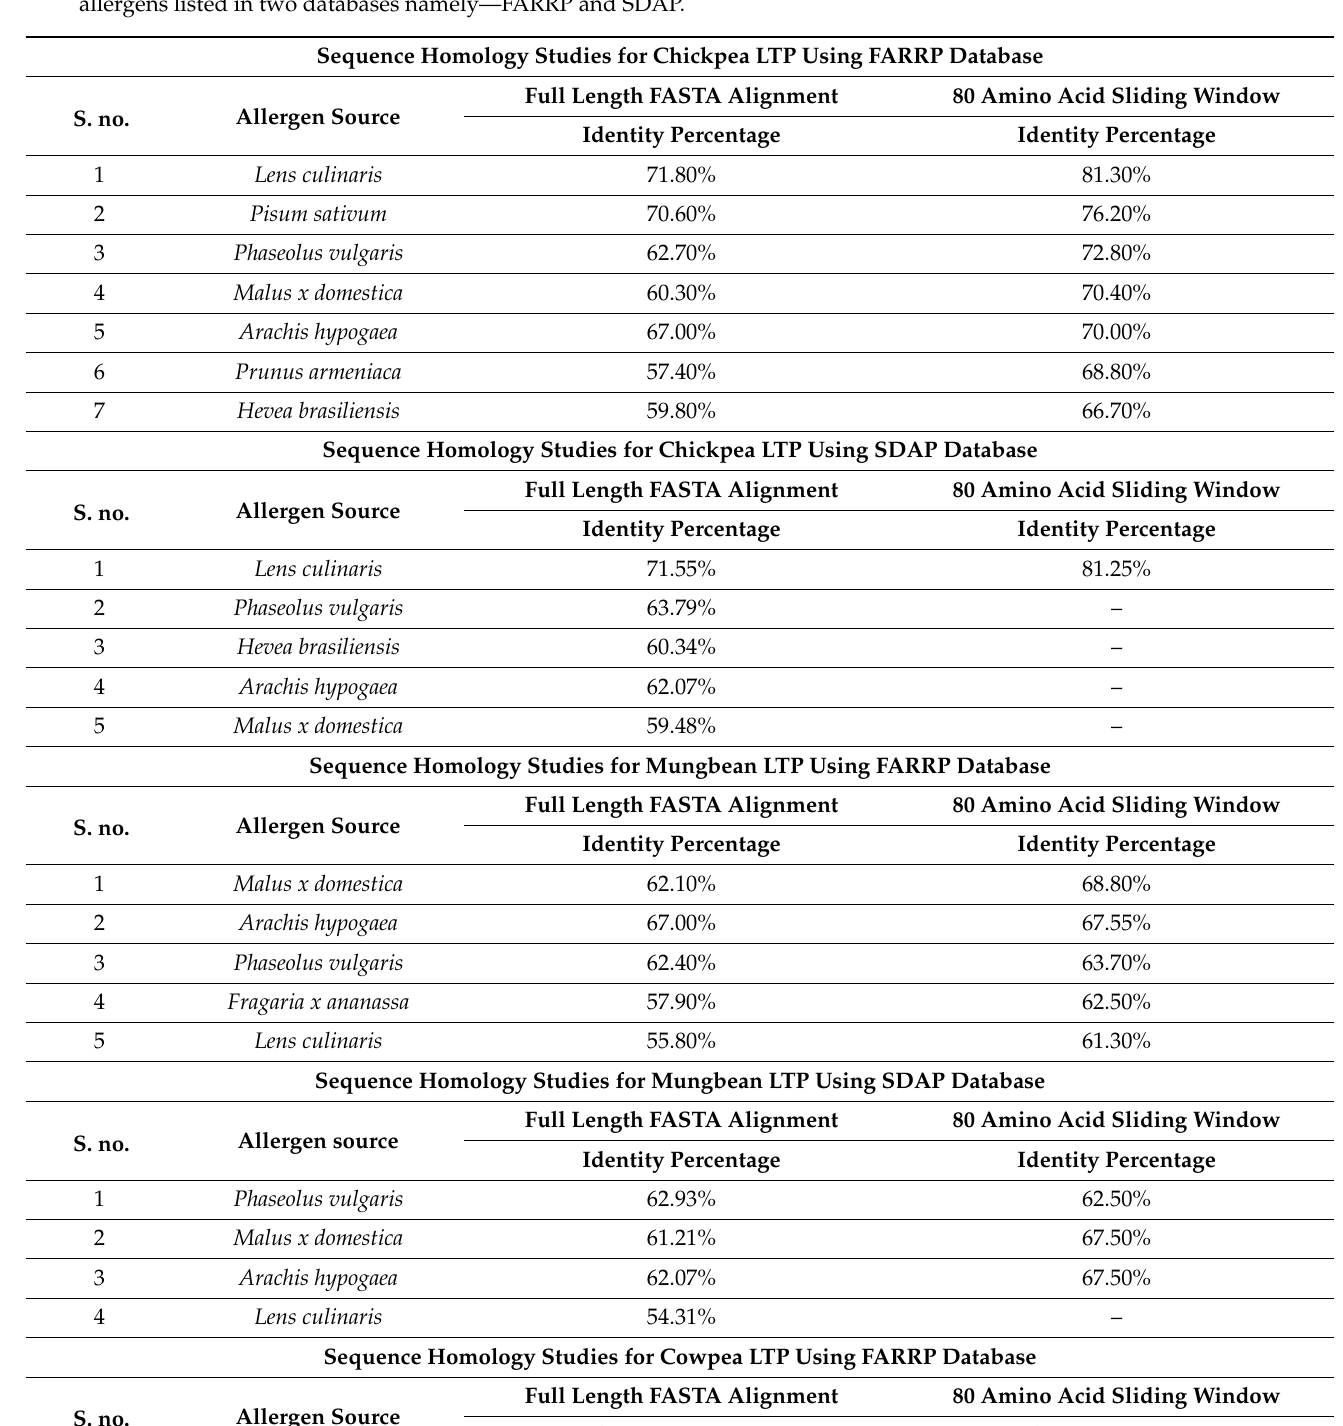
Table 1. LTP sequences from chickpea, mung-bean, cowpea, pigeon-pea and soybean shared sequence homology with the allergens listed in two databases namely—FARRP and